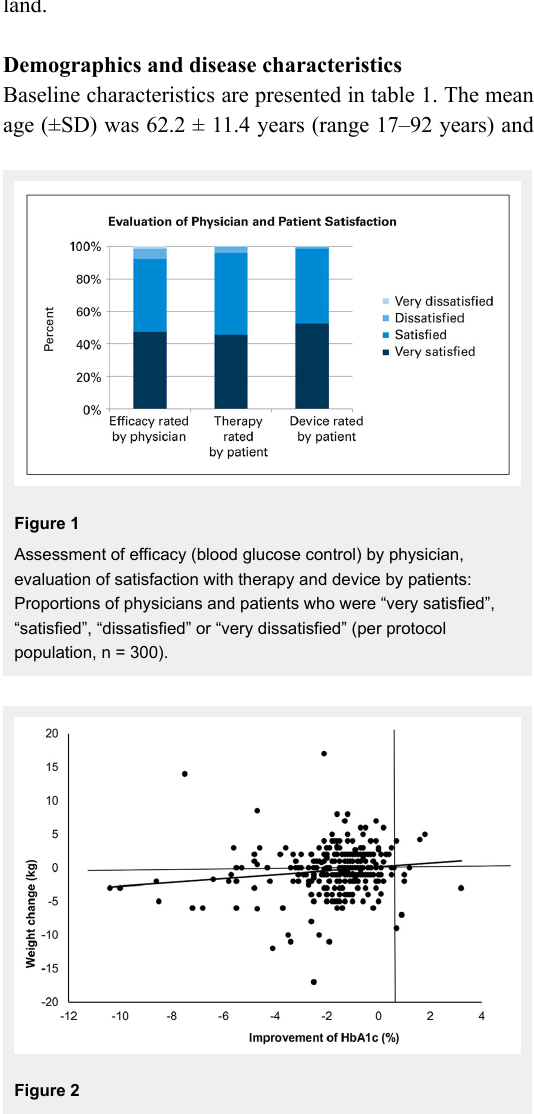
Weight change in relation to improvement of HbA 1c . Correlation of weight change and change in HbA 1c , p = 0.01.